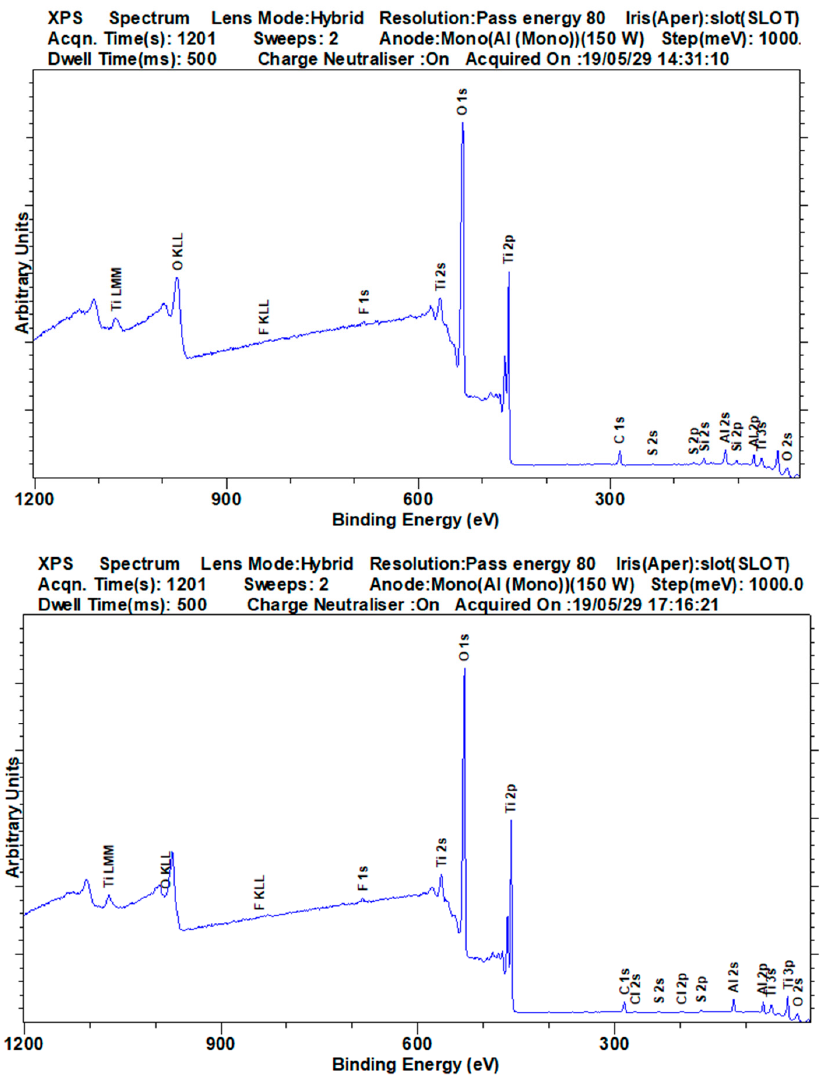
Figure 5. Survey XPS spectra of JRCNM62001a and JRCNM62002a titania nanoparticles with corresponding Versailles Project on Advanced Materials and Standards (VAMAS) information on top.